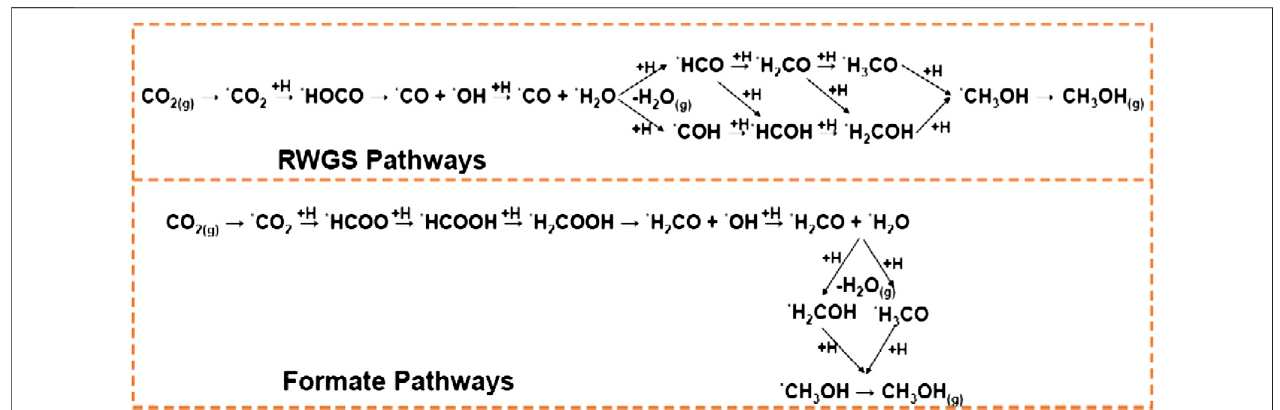
FIGURE 3 | Pathways for the CO 2(g) hydrogenation to CH 3 OH (g) over the surface of Cu-based catalysts.